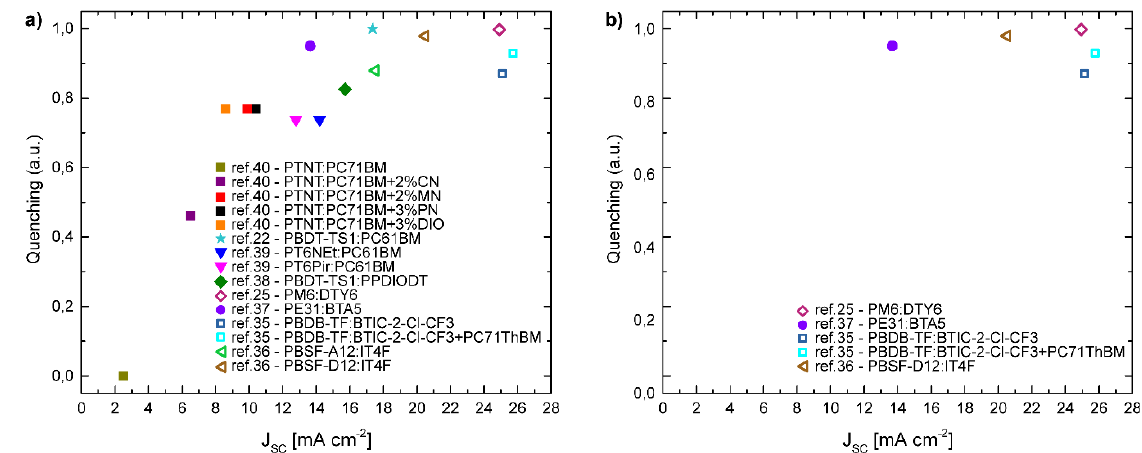
Figure 6. ( a ) Photoluminescence quenching as a function of photocurrent at short circuit, J SC , for a number of fullerene and non-fullerene acceptor based solar cells processed from non-halogenated solvents.[32,35,45,46,48,53 – 55] Halogenated and non-halogenated additives: 1-Methoxynaphthalene (MN), 1-Phenylnaphthalene (PN), 1-Cloronaphthalene (CN), 1,8-Diiodooctane (DIO). ( b ) A selection of data from panel (a) which exhibit high quenching.